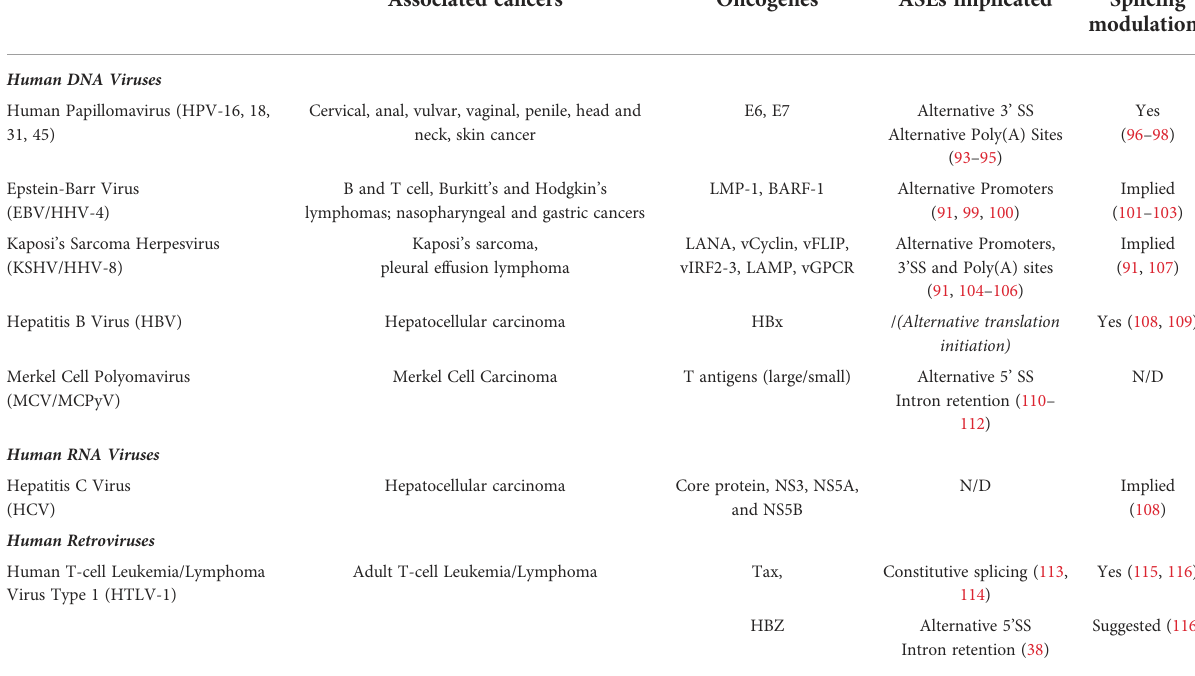
TABLE 1 Recapitulative table of human oncogenic viruses, associated cancers and alternative splicing regulation. Associated